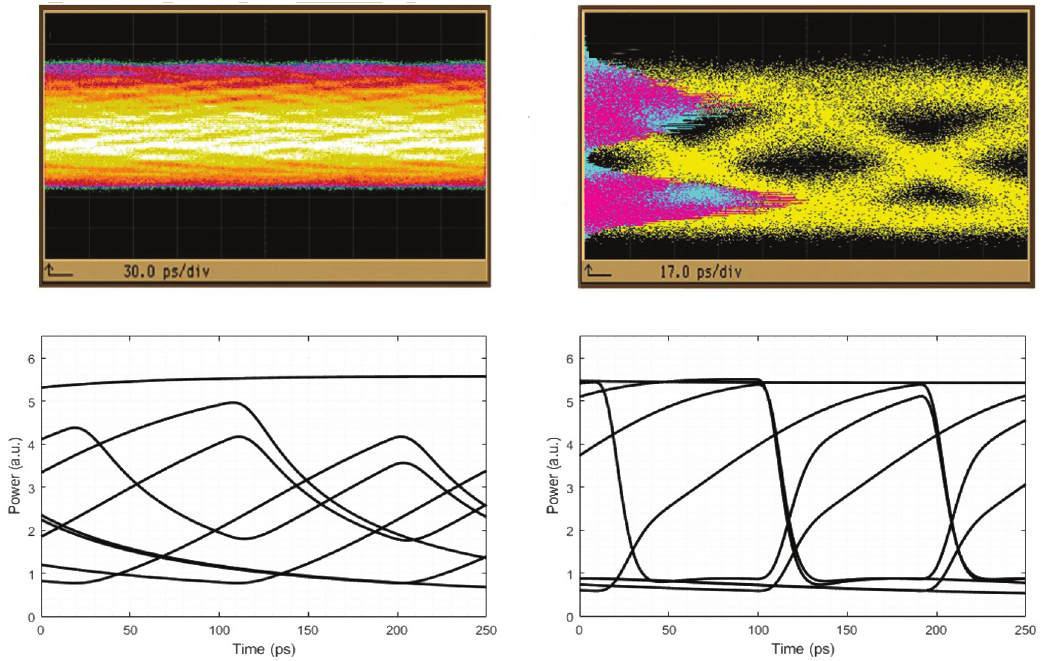
Figure 10. Encoded signal eye diagrams at RSOA output ( left column ) and BFL output at 11 Gb/s ( right column ). Upper row : Experimental results. Lower row : Simulation